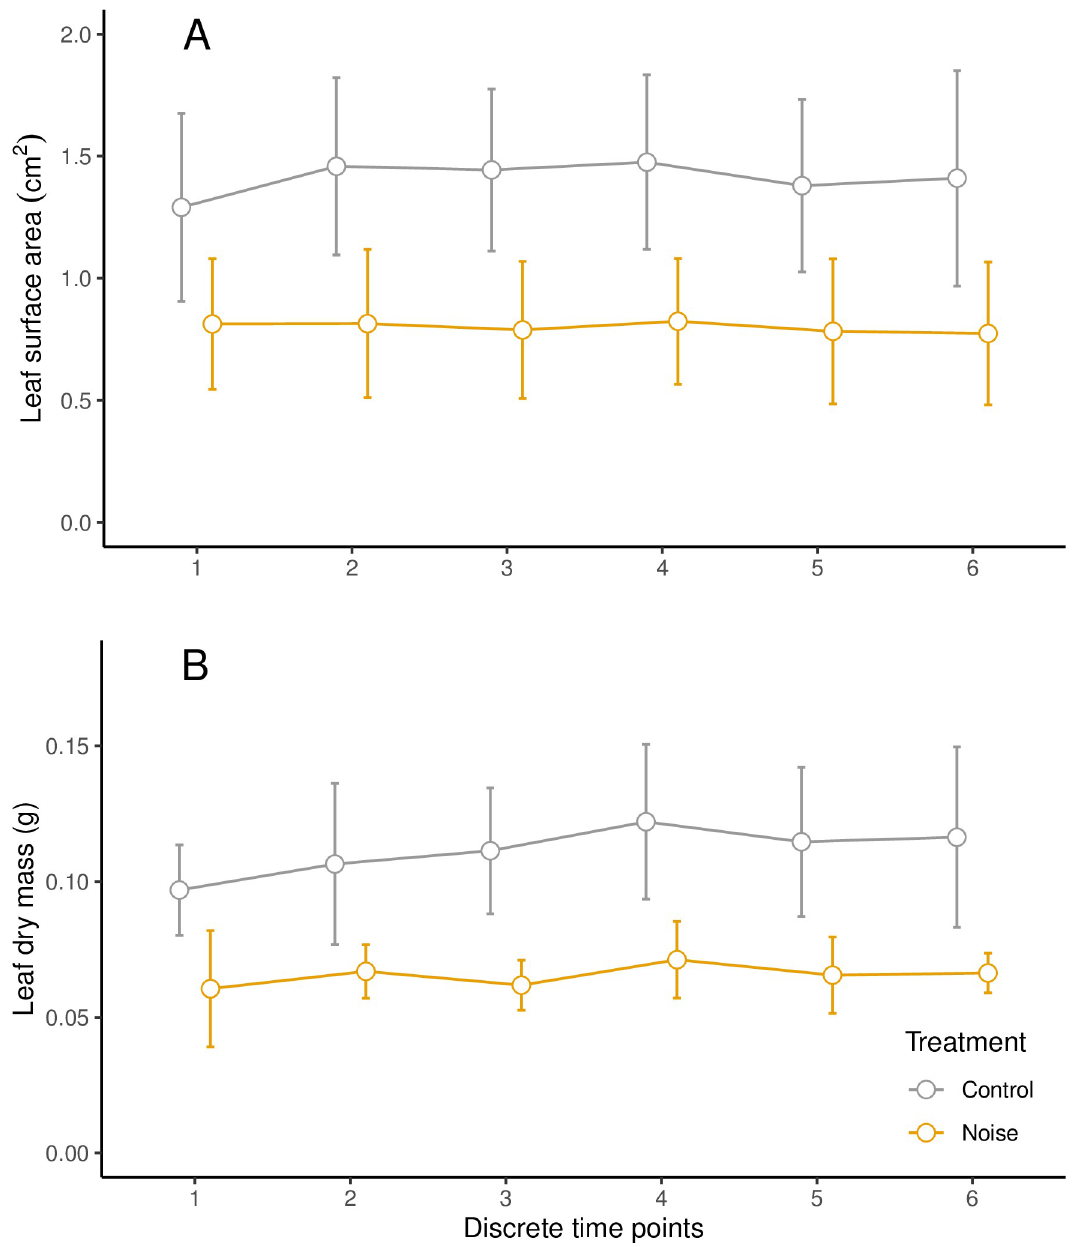
Fig 3. Mean ( ± SD) of foraged leaf fragment A) surface area (cm 2 ) and B) dry mass (g) by A . octospinosus under noise and control treatments recorded at six discrete time points within each foraging replicate (n = 10). noise exposure. Ants did not recruit fewer foragers under noise conditions as colony activity rates were not impacted. During noise trials leaf size (weight and surface area) was consistently reduced from the first time point through to the final recording point in each replicate. Fur- thermore, consistent differences in leaf size throughout the replicates suggest the colony did not become habituated to the experimental noise treatment. Experimental exposure to noise had clear effects on the foraging behaviour and resource acquisition of leafcutter ants, which may limit the colony’s fitness over time.